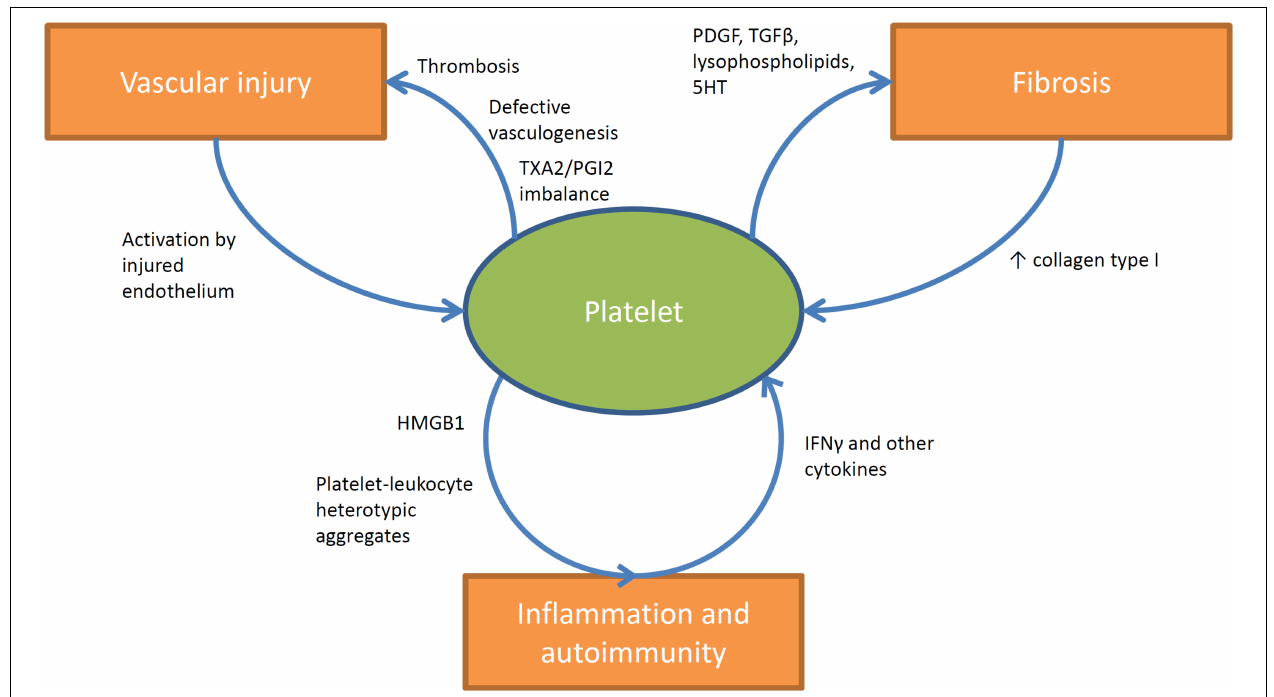
prototypic alarmin have been shown to correlate with disease activity in SSc. Moreover evidence is growing about the prominent role of circulating heterotypic aggregates (between platelets and innate immune cells) in the pathogenesis of inflammatory and vascular diseases and recent studies are currently evaluating their impact in the pathogenesis of SSc. Furthermore other studies suggested the existence of a specific network between collagen-reactiveT lymphocyte and platelets in SSc. In this latter setting platelet activation would be enhanced by the release of IFN γ and a wider array of cytokines from autoreactiveT lymphocyte, which in turn would affect megakaryocyte maturation and platelet basal activation